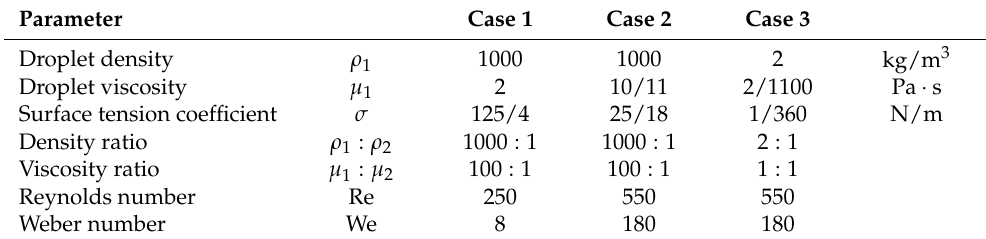
Table 4. Material and system properties for the colliding droplet cases.